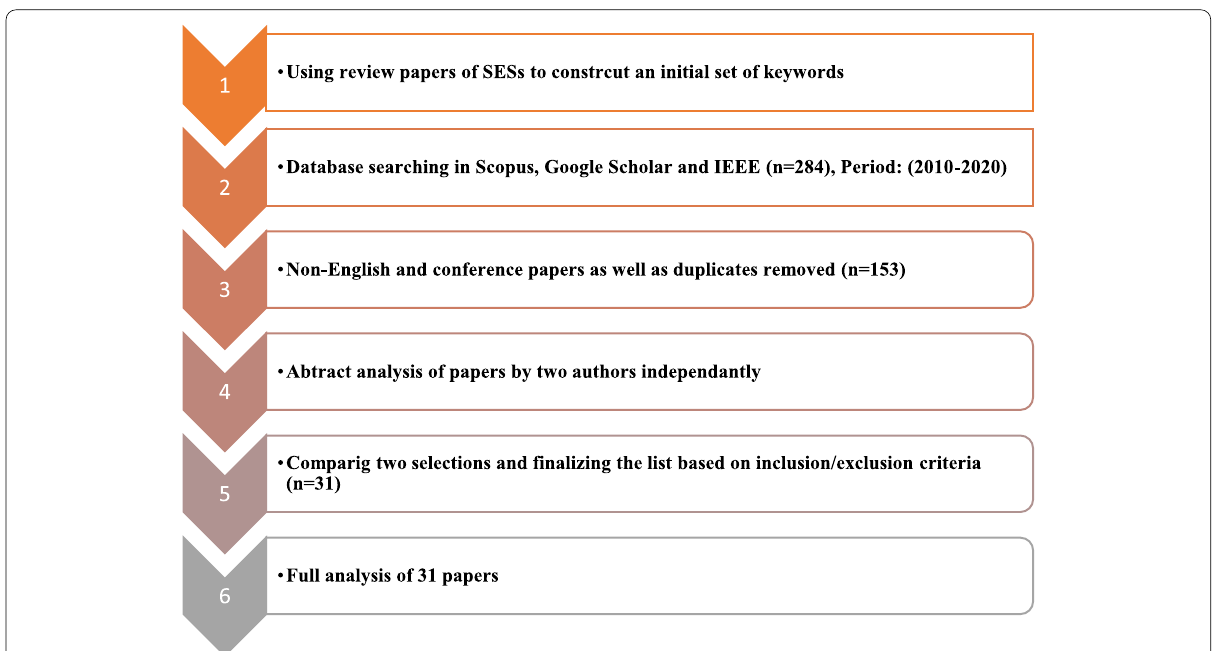
Fig. 1 The process of conceptual literature